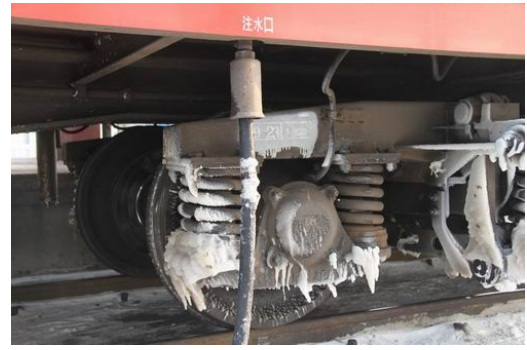
Figure 1. Low wheel-rail adhesion state of the train. The air braking force B is affected by several braking parameters, namely: 2 where d is the diameter of brake cylinder, r is the friction radius of the brake disc, R c is the diameter of the wheel, and N is the total number of brake pads. These parameters cylinder. During the actual emergency braking, all air pressures will be released. η is the transmission efficiency of the foundation brake device. It reflects the friction between the piston and the cylinder wall, the reverse force of the brake cylinder to release the spring, and the mechanical friction of the transmission mechanism. γ B is the braking ratio. It represents the ideal expansion multiple of the brake cylinder piston rod when the force is transferred to the brake disc. µ A is the friction coefficient of the brake disc. It changes with the train running state and the brake disc material. As shown in Figure 2, when the train brake disc faults occur, such as degradations or even friction failures, it will lead to the performance decline of the train brake. Even if the brake cylinder applied the maximum air pressures, the train still cannot stop in line with the expected braking distance.